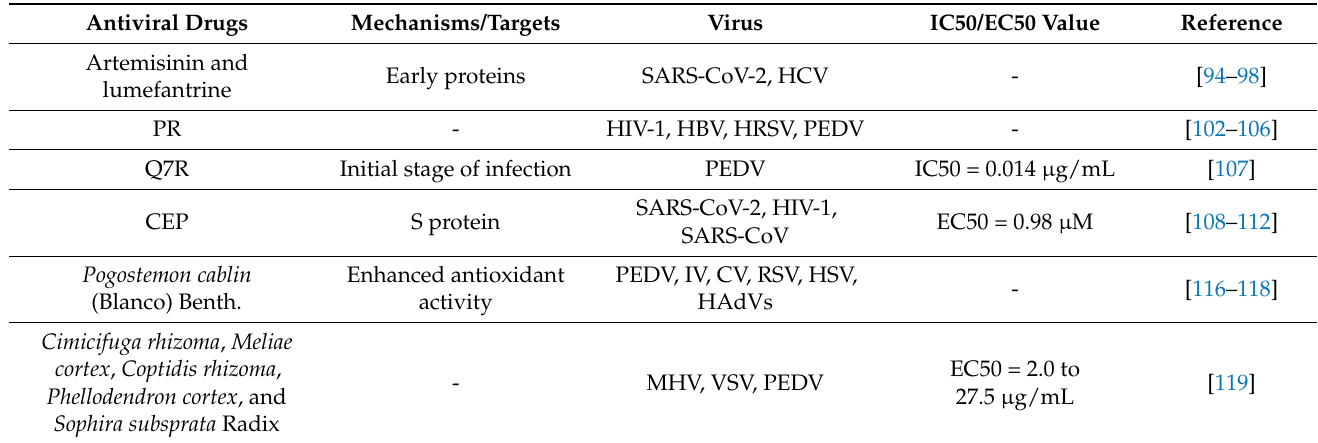
Table 5. Antiviral TCM and the antiviral